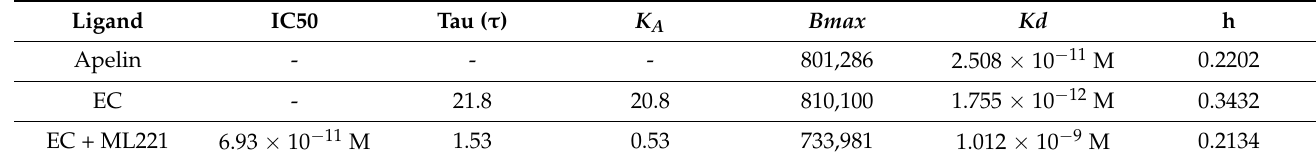
Table 3. Reported effects of EC-interacting isolated receptors on skeletal muscle.